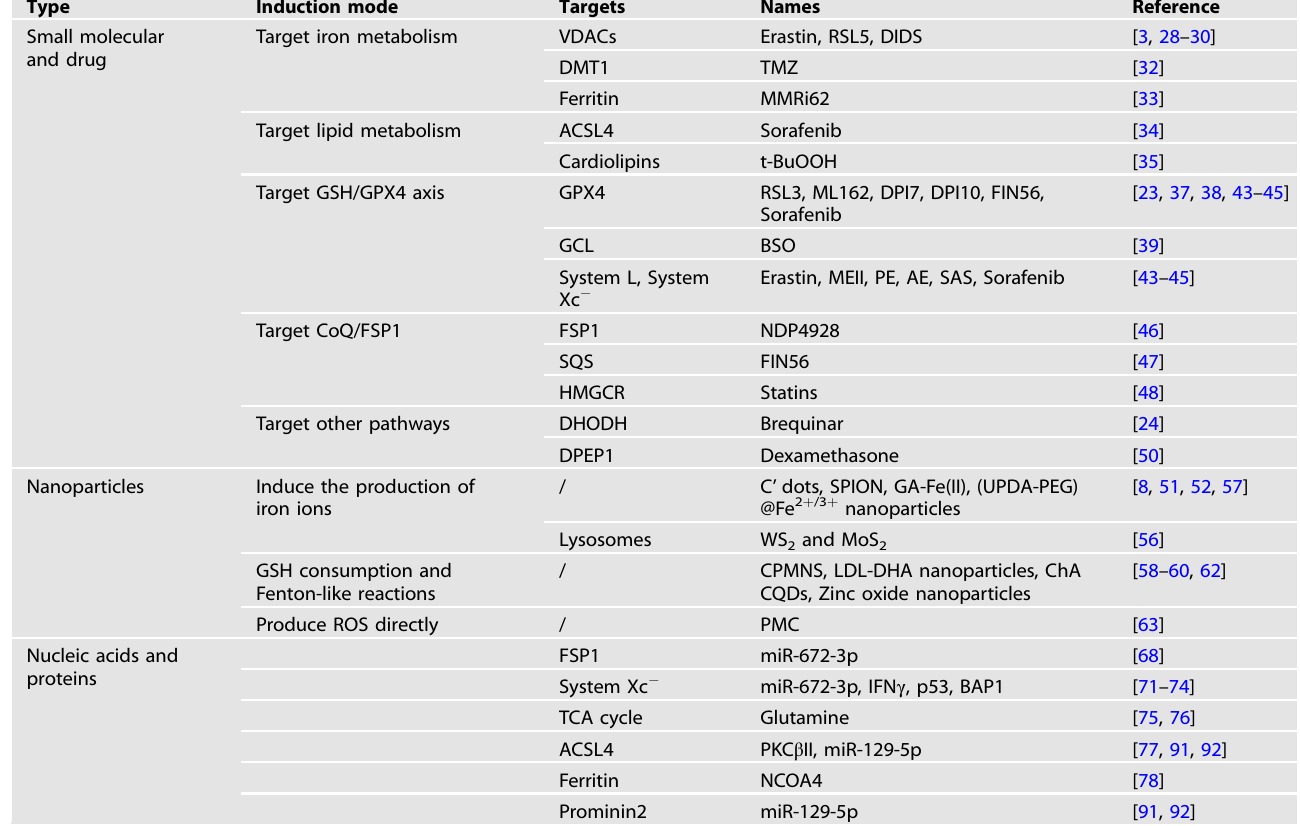
Table 1. Examples of ferroptosis